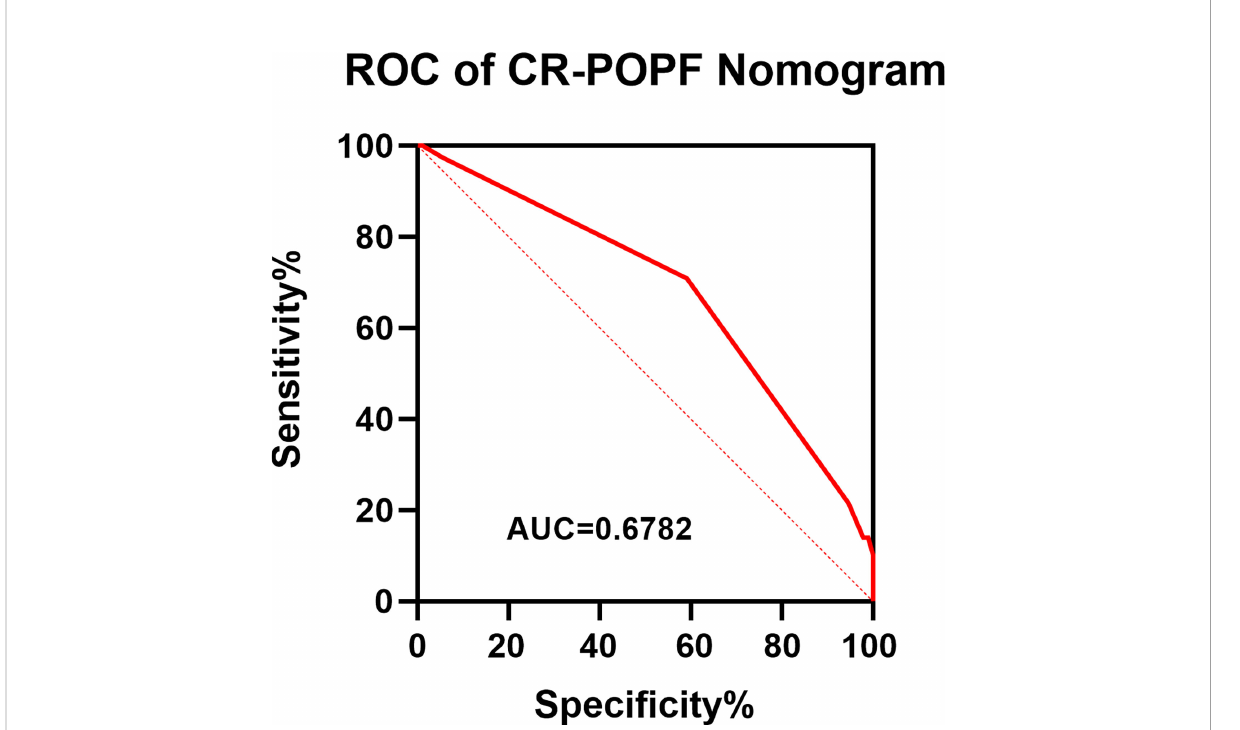
FIGURE 6 Calibration plot of nomogram predicts CR-POPF. The X – axis represents the nomogram – predicted survival, while the actual survival was plotted on the Y – axis. And the apparent incidence of CR-POPF, the ideal incidence, the bias-corrected incidence were shown as different